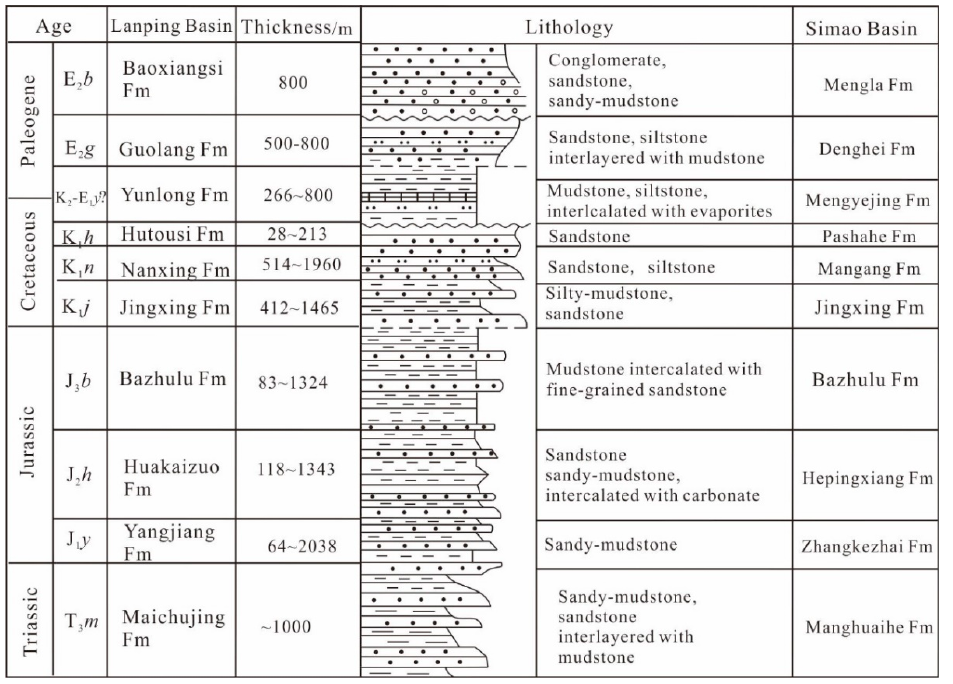
Figure 2. The synthesized stratigraphic column of the Mesozoic-Tertiary sedimentation (modified from [29]).